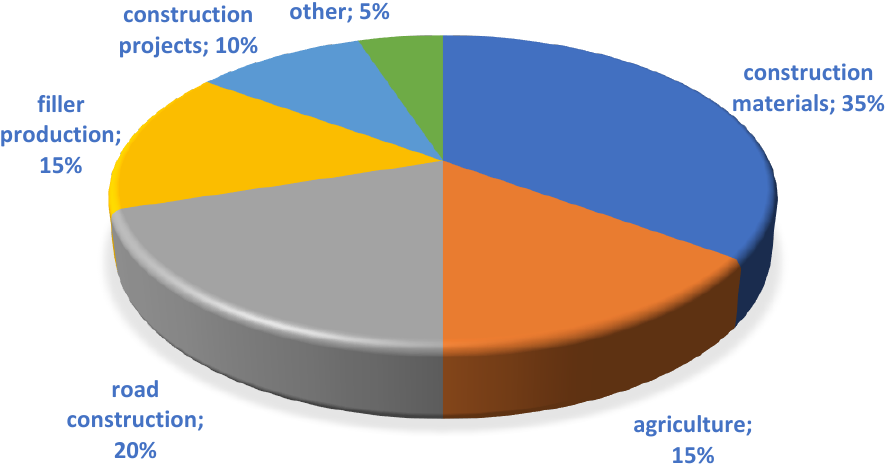
Figure 1. Applications of coal ash [23 – 25].